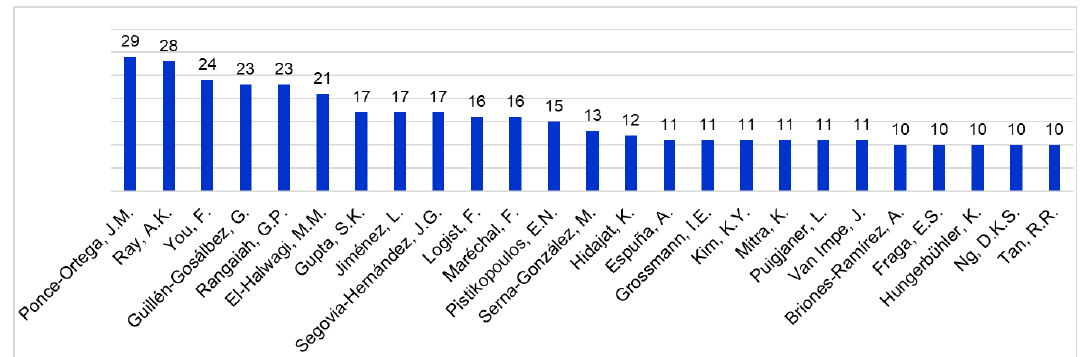
Figure 4. Researchers who (co-)authored 10 or more papers in Figure 3.